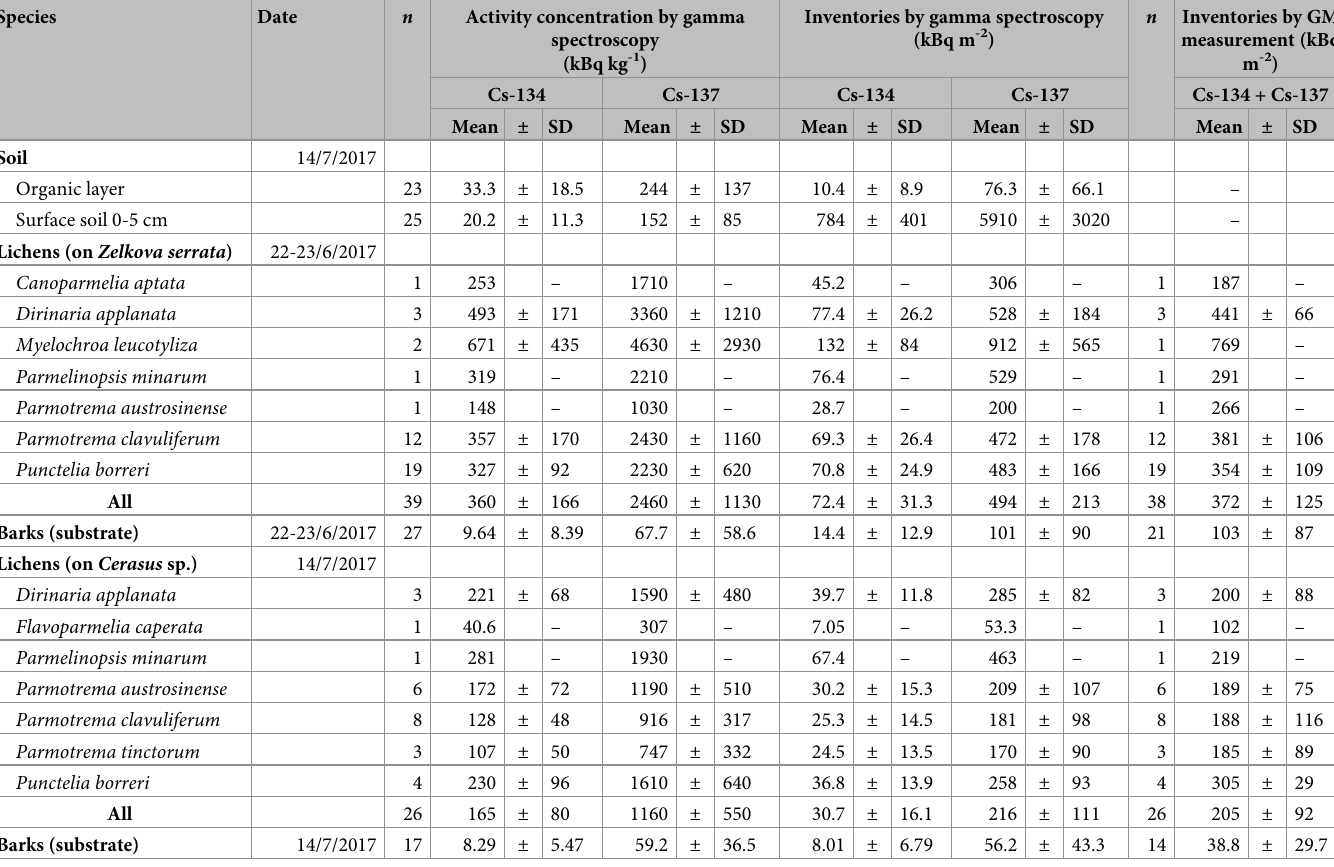
Table 1. Radiocaesium activity concentrations and inventories in lichen thalli and tree bark in the site boundary of the FDNPS. Species Date n Activity concentration by gamma